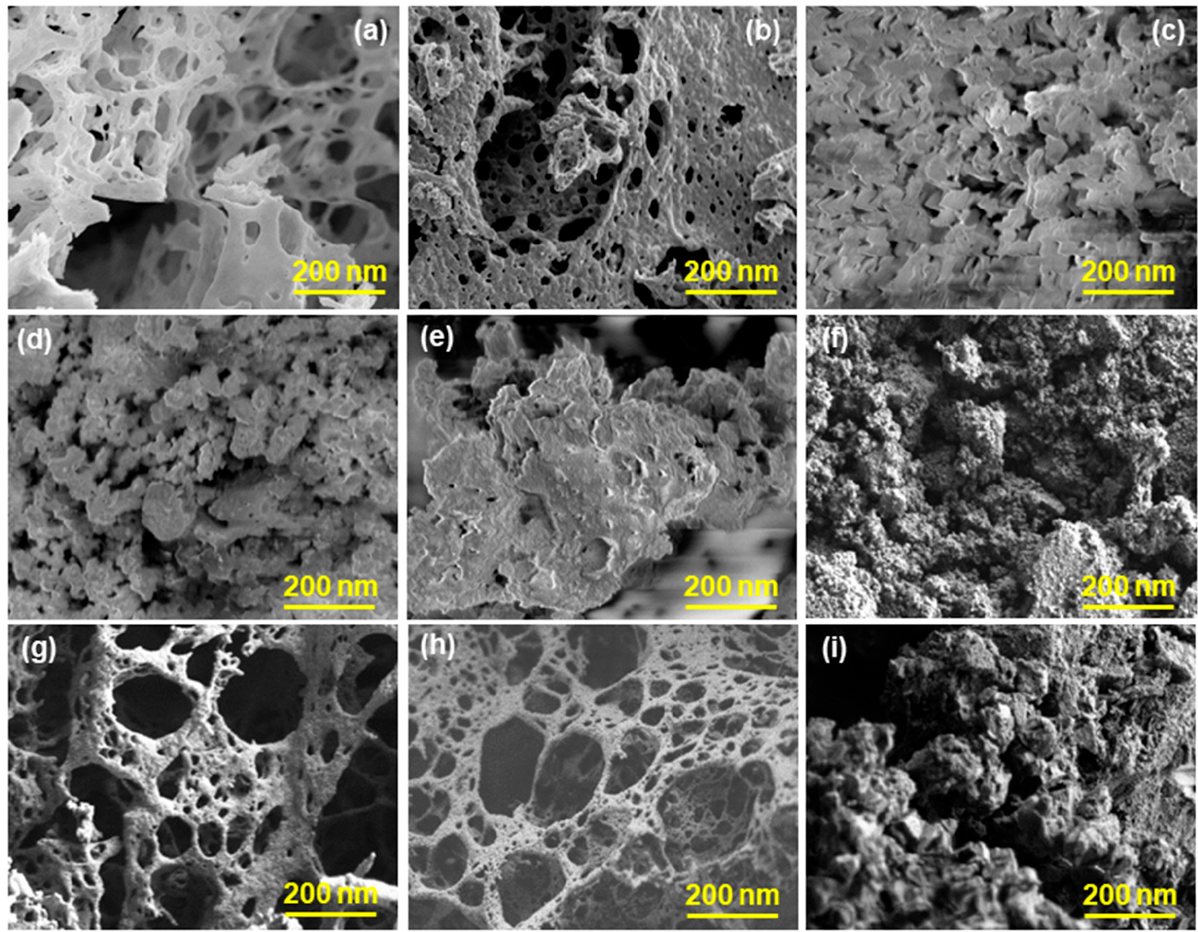
Figure 2. The SEM images of the prepared ( a ) CoO-OP, ( b ) Co 3 O 4 -OP-C, ( c ) Co 3 O 4 -NaOH, ( d ) Co 3 O 4 - S-OP, ( e ) Co 3 O 4 -S-OP-C, ( f ) Co 3 O 4 -S-NaOH, ( g ) CoO-P-OP, ( h ) Co 3 O 4 -P-OP-C, ( i ) Co 3 O 4 -P-NaOH nanomaterials at the scale of 200 nm.